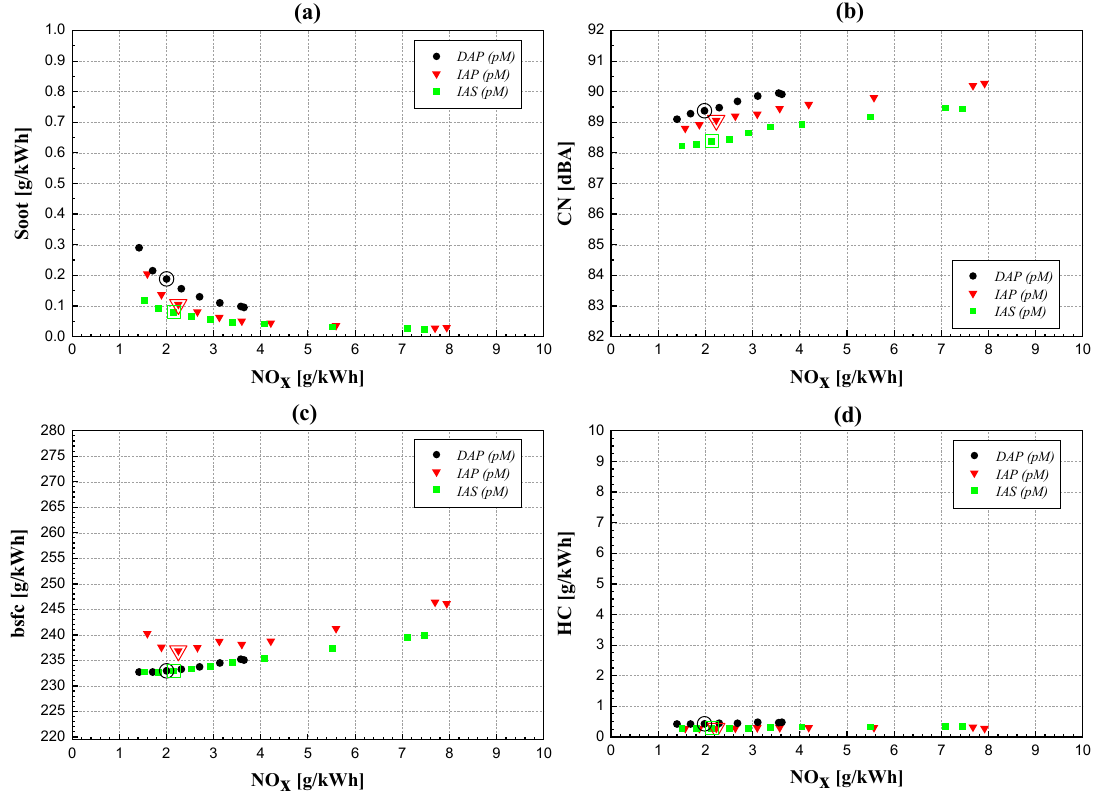
Figure 10. Engine-out soot emissions ( a ) CN; ( b ) bsfc ; ( c ) and engine-out HC emissions; ( d ) vs NO x for the three injector typologies, at 2500 × 8.